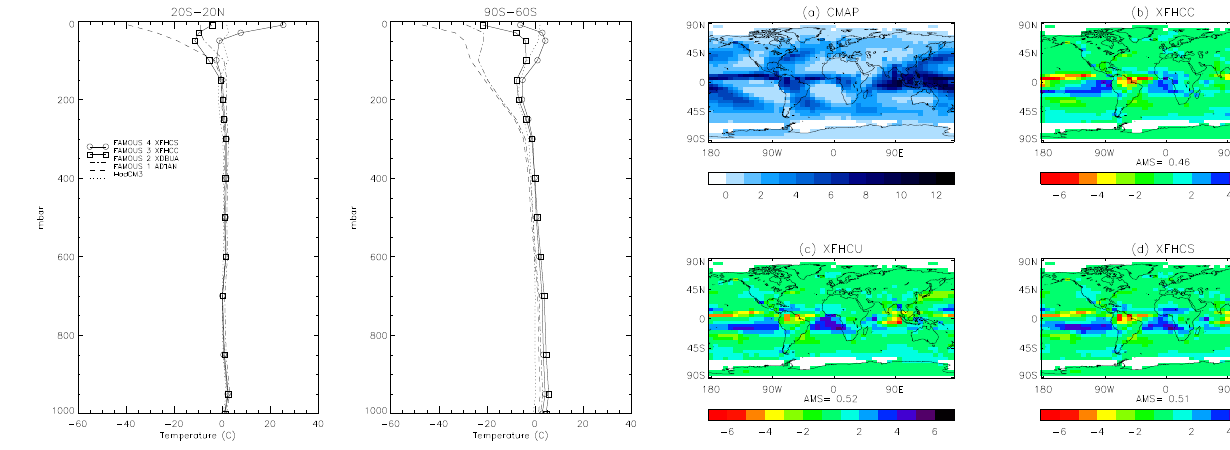
Fig. 11. Mean temperature profiles for 20 ◦ S–20 ◦ N (left) and 90 ◦ S–60 ◦ S (right) for HadCM3 (dotted line), generation 1 FA- MOUS, ADTAN (dashed line), generation 2, XDBUA (dotted- dashed line), generation 3, XFHCC (squares) and generation 4b, XFHCS (circles). The generation 4a model, XFHCU is not shown since its temperature profile is virtually indistinguishable from the generation 4b version, especially in the stratosphere.